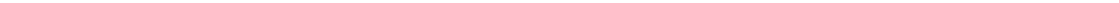
Fig. 4 NLRP11 speci fi cally associates with TRAF6 but not TRAF2. a 293T-TLR4 cells or 293T cells were co-transfected with a NF- κ B and TK-Renilla reporter along with increasing amounts of NLRP11 for 24 h and then left untreated or stimulated with LPS or TNF for 6 h before a luciferase assay. NF- κ B promoter- driven luciferase activity was measured and normalized to the Renilla luciferase activity. b Luciferase activity in 293T cells transfected with the NF- κ B or IFN- β luciferase reporter, together with a vector encoding MyD88, IRAK1, TRAF2, TRAF6, IKK α , p65, or TBK1, along with the empty vector or with increasing amounts of a vector encoding NLRP11. The results are presented relative to Renilla luciferase activity. c Schematic overview of TLR4- and TNFR- mediated NF- κ B activation, regulated by NLRP11. d Immunoprecipitation and an immunoassay of lysates of 293T cells transfected with a vector expressing HA-tagged NLRP11 along with the empty vector or vector encoding Flag-tagged TRAF2 or TRAF6. e – g THP-1 cells e , THP-1-derived macrophages f , or PBMCs g were stimulated with LPS for the indicated periods. The cell lysates were subjected to immunoprecipitation with an anti-TRAF6 antibody or control IgG, followed by immunoblotting with an anti-NLRP11 or anti-TRAF6 antibody. h A structural diagram of NLRP11 as well as schematic representation of Flag-tagged truncation mutants of NLRP11. The numbers indicate amino acid positions. i 293T cells were transfected with HA-tagged TRAF6 and Flag- tagged NLRP11 (FL) or NLRP11 truncation mutants. The cell lysates were subjected to immunoprecipitation with anti-Flag antibodies and immunoblotted with the indicated antibodies. j Luciferase activity in 293T cells transfected with an NF- κ B luciferase reporter, together with a vector encoding TRAF6, along with the empty vector or with vectors encoding NLRP11 or its mutants. The results are presented relative to Renilla luciferase activity. Data a , b , and j are expressed as mean ± SEM of combined from three independent experiments with triplicate; * P < 0.05, ** P < 0.01, and *** P < 0.001 compared to the same treatment in control cells (Student ’ s t -test). Data d – g and i are representatives of three independent experiments with similar